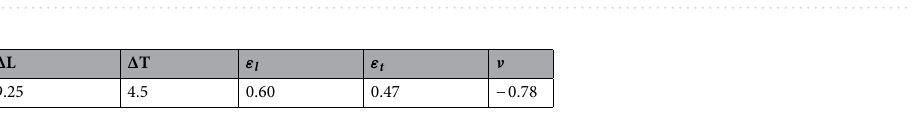
Figure 8. Dry fibre honeycomb ( a ) and auxetic ( b ) preforms. Length and height measurements at the start ( c ) and the end ( d ) of the manual testing of auxetic preform.